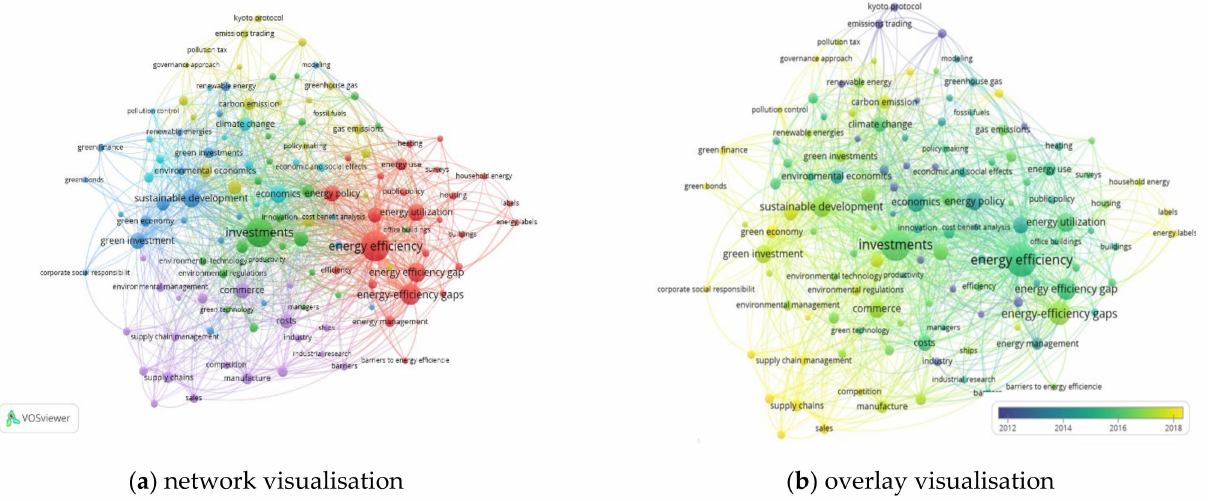
Figure 1. The finding of co-occurrence analyses: network and overlay visualisation (source: developed by the